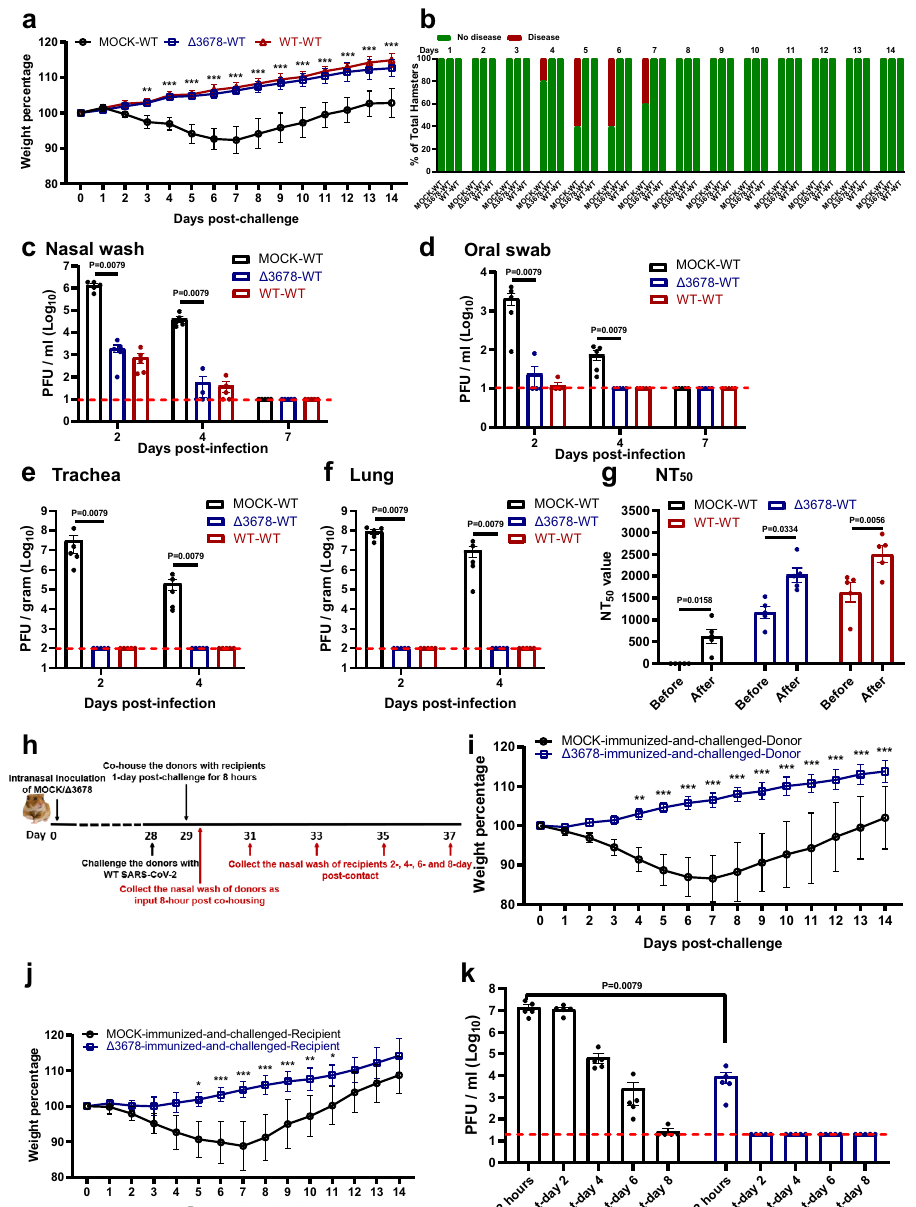
Fig. 3 | Protection of Δ 3678 virus-immunized hamsters from WT SARS-CoV-2 challenge and transmission. a Weight loss of immunized and-challenged hamsters ( n = 5). The data are shown as mean ± standard deviation. The weight changes were statistically analyzed using two-way ANOVA (two-sided) with Tukey ’ s post hoc test. The statistic difference between the Δ 3678- and mock- immunized groups are indicated. The exact P values are 0.0049 (day 3) and P < 0.0001 (days 4 – 14). b The percentages of animals with or without diseases were presented. c – f Viral loads in the nasal wash ( c ), oral swab ( d ), trachea ( e ), and lung ( f ) after challenge. Dots represent individual animals ( n = 5). The values of mean ± SEM are presented. A non-parametric two-tailed Mann – Whitney test was used to determine the statistical differences. P values were adjusted using the Bonferroni correction to account for multiple com- parisons. Differences were considered signi fi cant if p < 0.025. g Neutralization titers of immunized hamsters before and after challenge. Dots represent individual animals ( n = 5). The values in the graph represent the mean± SEM. A